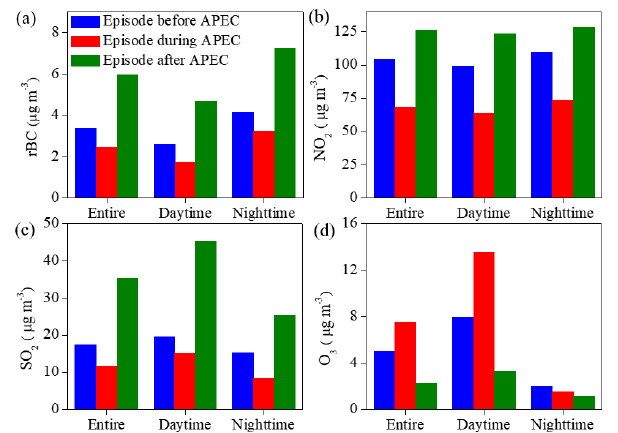
Figure 2. The mass concentrations of (a) rBC, (b) NO 2 , (c) SO 2 and (d) O 3 for the pollution episodes before, during and after APEC. We separated the entire data sets into daytime (07:00 to 19:00LT) and nighttime (19:00 to 07:00LT of the following day)